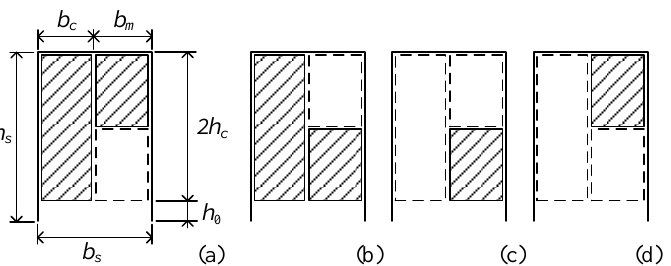
Figure 5. Overview of possible coil sides belonging to one phase placements in one slot: central and one marginal coil ( a , b ), and only marginal coil ( c , d ).